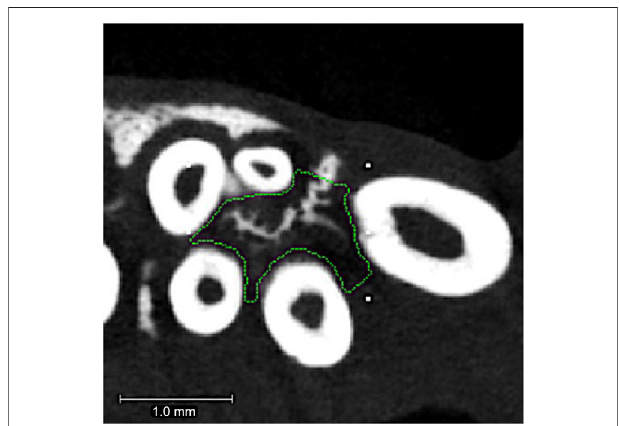
FIGURE 3 | Alveolar bone region of interest. Micro-CT axial slice image showing region of interest for the maxillary fi rst molar intra-radicular alveolar bone. The region of interest (ROI) is outlined in green. This ROI extended from the molar root furcation to the apex of the root and did not include the tooth roots themselves. Tiny white rectangles are orientation marks placed by the operator prior to custom outlining the 3D intra-radicular ROI for analysis.